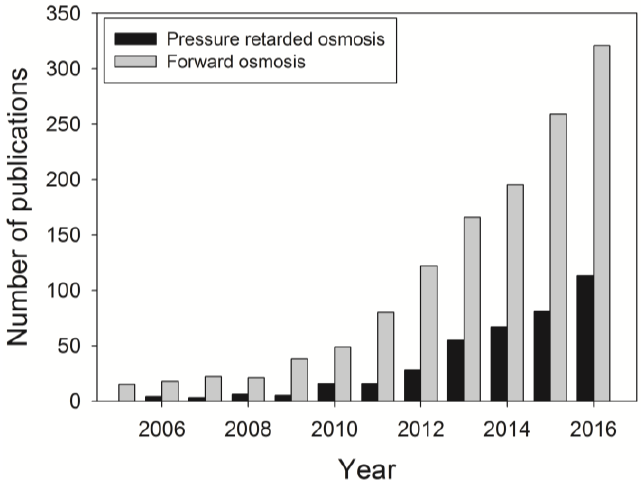
Figure 1. Increase in publications on forward osmosis between 2005 and 2016. The number of publications is calculated based on the Scopus database using keywords “forward osmosis” and “pressure retarded osmosis”.